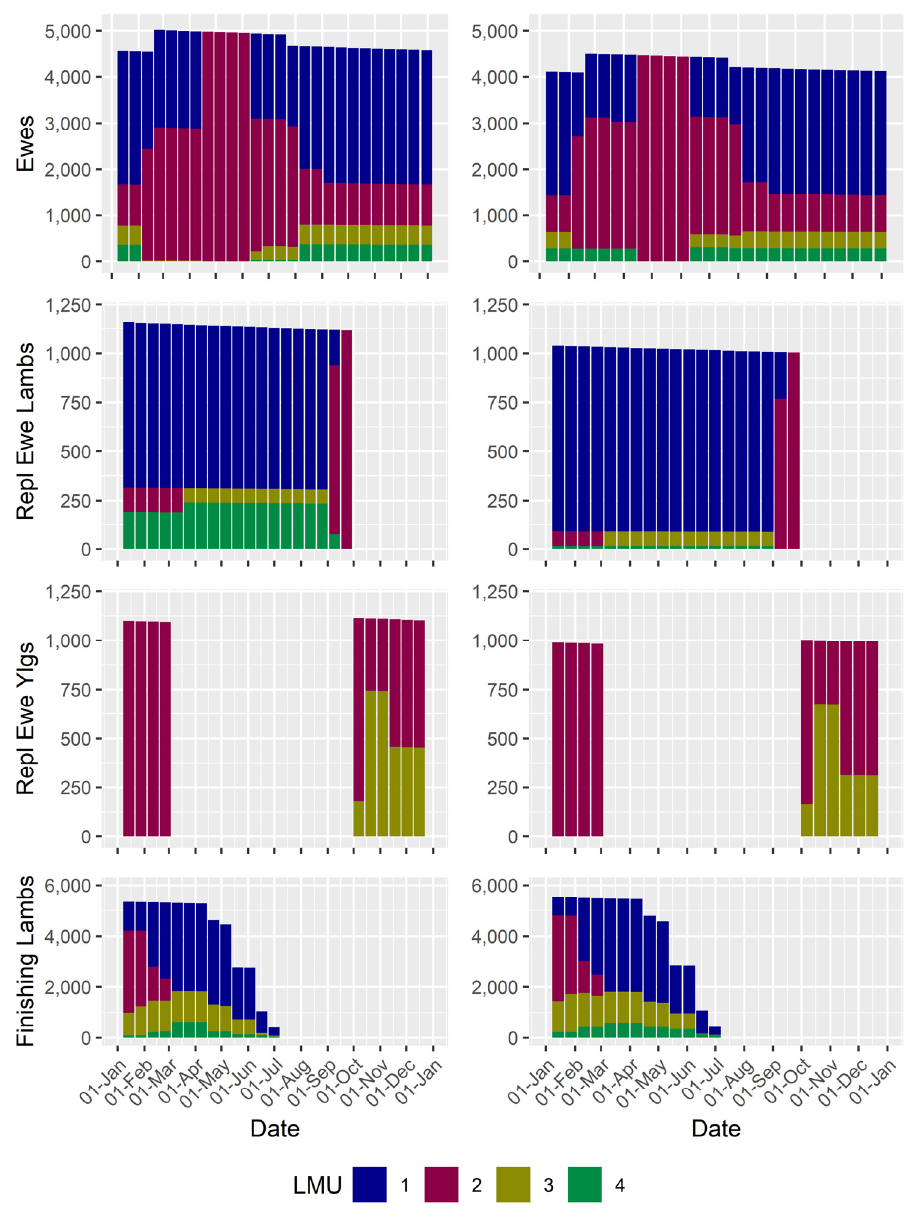
Figure 3. The fortnightly location and number of ewes, their replacements and lambs that are finished and sold over the year for the farm-level case (Base farm) ( left column ) and farm-level case (Fecund farm) ( right column ) options.